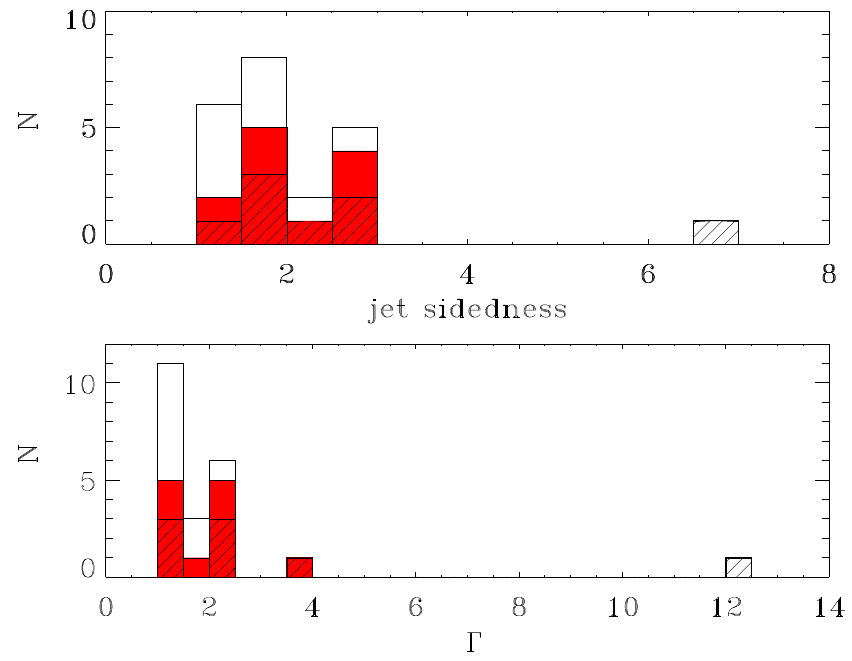
Figure 6. Upper panel: histogram of jet-to-counter-jet sidedness from our sample (white histogram) and the sample from [87,88] (red histogram) obtained from VLBI, EVN, and VLBA data. Lower panel: distribution of the jet bulk Lorentz factor Γ , estimated from the jet sidedness (see the text in Section 4). The shaded areas represent the lower limits of the jet sidedness and Γ for the one-sided